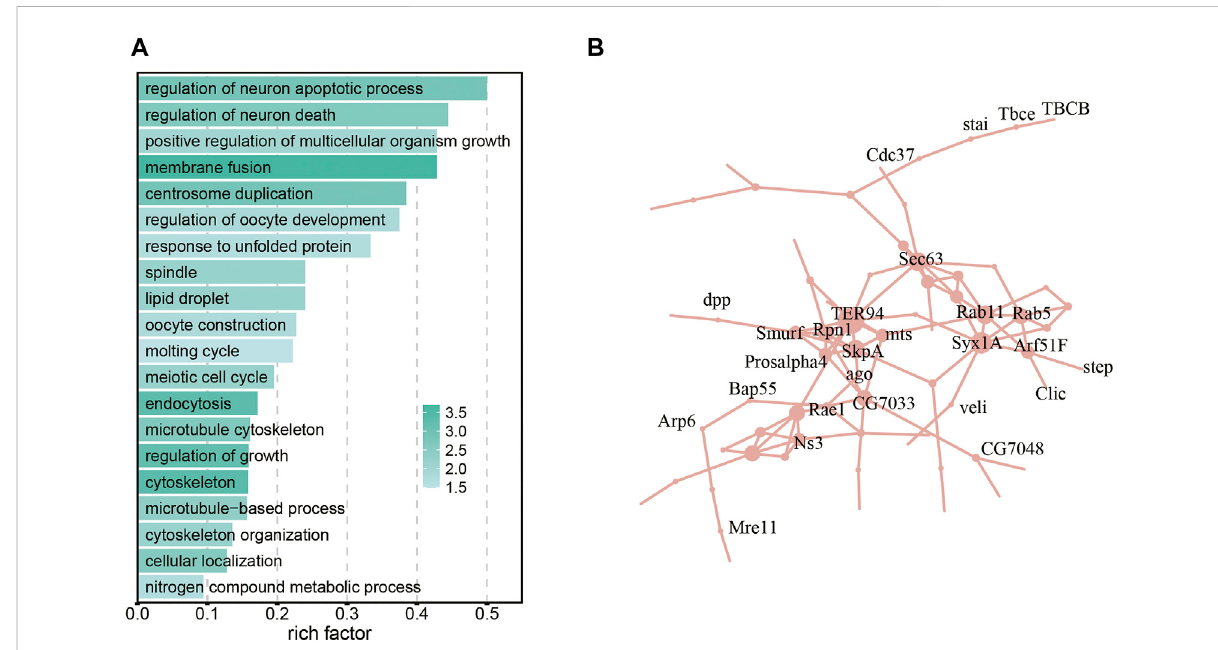
FIGURE 3 Accelerated evolution of the embryogenesis genes in the eggs of A. gigantea. (A) . The bar plot shows the GO enrichment results of the accelerated evolution genes; (B) . A network of the accelerated evolution genes in the A. gigantea ’ s